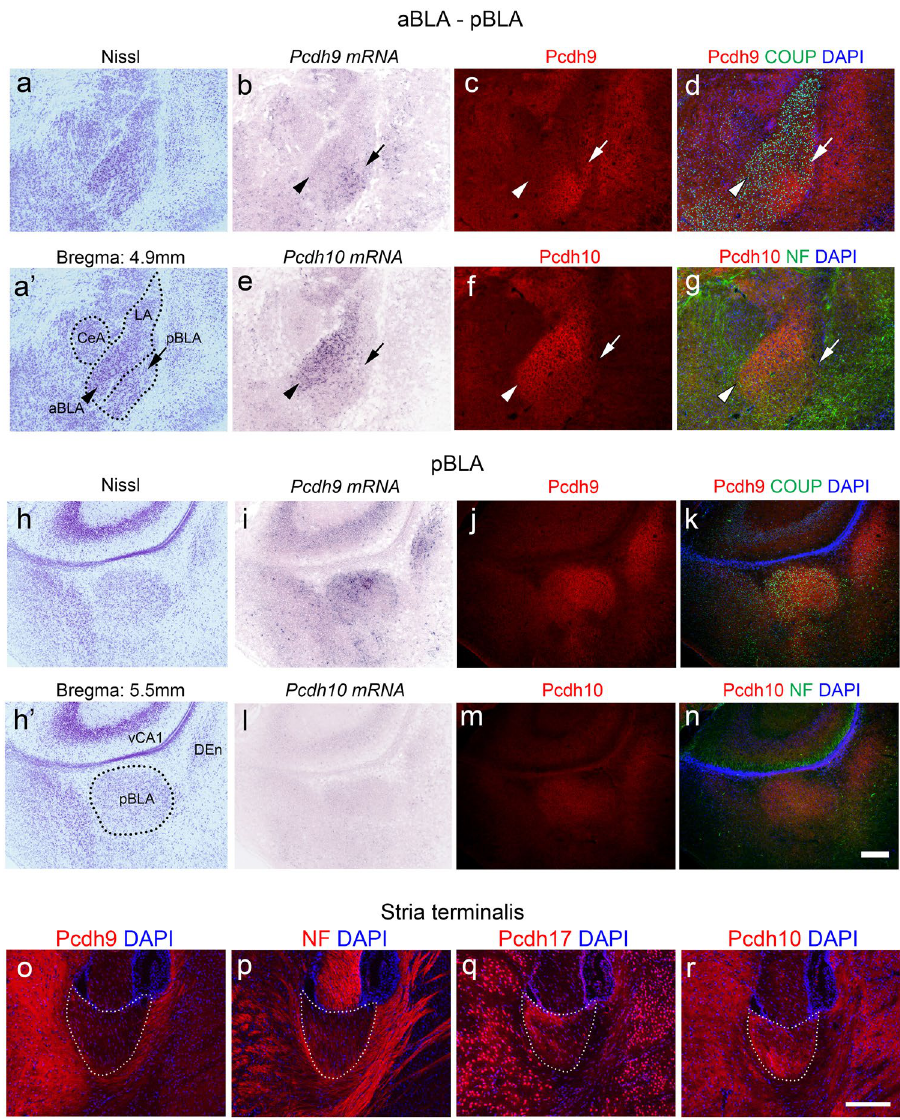
Figure 1. Expression and distribution of Pcdh9 gene products in the amygdala and stria terminalis. ( a – n ) Expression and distribution of the Pcdh9 gene products in the amygdala region in comparison to that of the Pcdh10 . ( b – d ) and ( i–k ) Show the Pcdh9 gene products in the aBLA and pBLA regions, respectively. Similarly, ( e – g ) and ( l – n ) Show the Pcdh10 gene product in the aBLA and pBLA regions, respectively. ( o – r ) Staining of the stria terminalis with various anti-protocadherin antibodies. Most of the fibres in the stria terminalis were Pcdh9 negative, whereas Pcdh10 and Pcdh17 were positive in the subsets of fibres. Abbreviation: NF, neurofilament. Scale bars, 200 μm in ( a – n ) and 100 μm in ( o – r